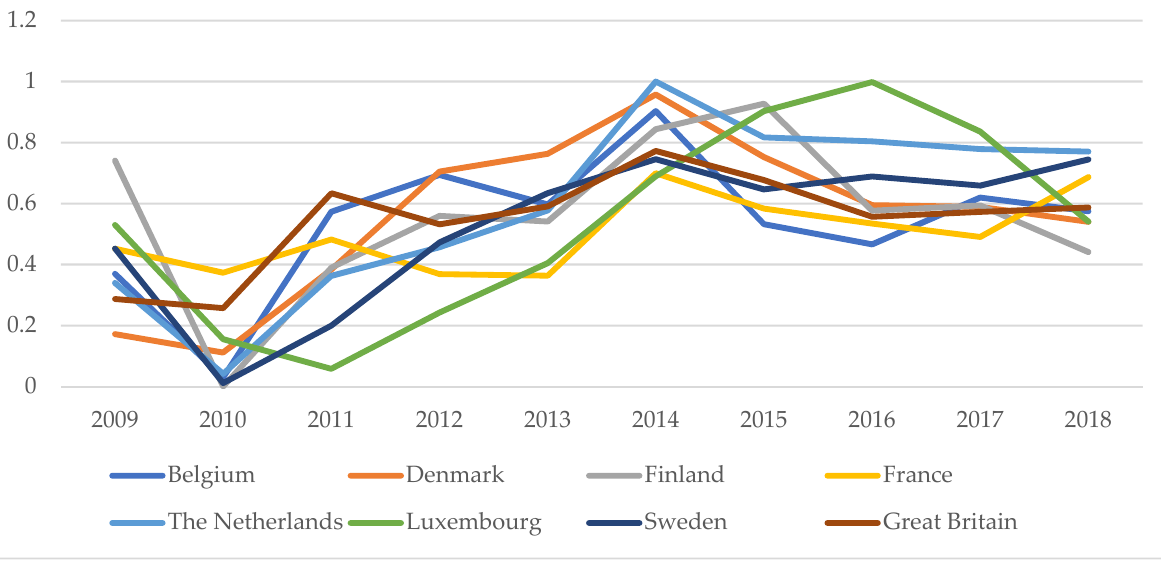
Figure A2. Trends in GHG emissions in 2009–2018, TOPSIS value index. Source: Reproduced from [16], Eurostat: 2009—2018.